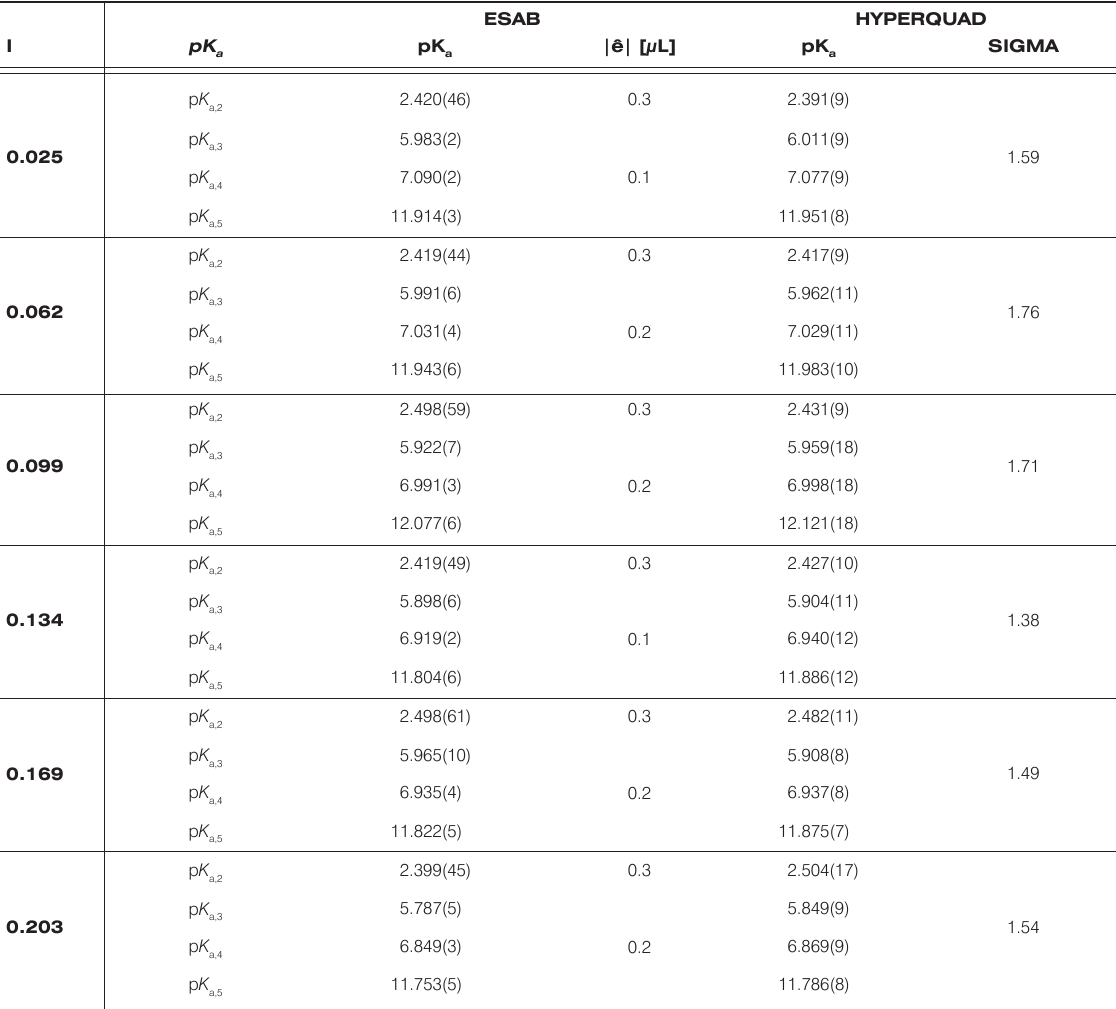
Table 5. Mixed dissociation constants p K of risedronate at 25°C and various values of an ionic strength I estimated by nonlinear regression a,i programs ESAB and HYPERQUAD. Standard deviations of parameter estimates in last valid digits are in